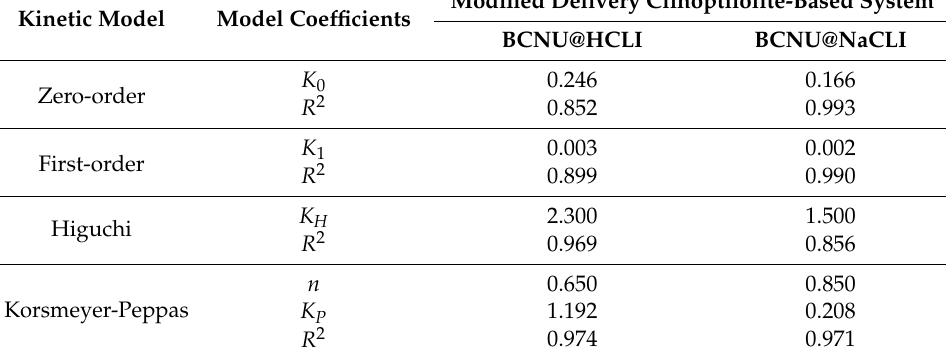
Table 2. Results of curve fitting of in vitro BCNU release profile from modified delivery clinoptilolite-based systems.